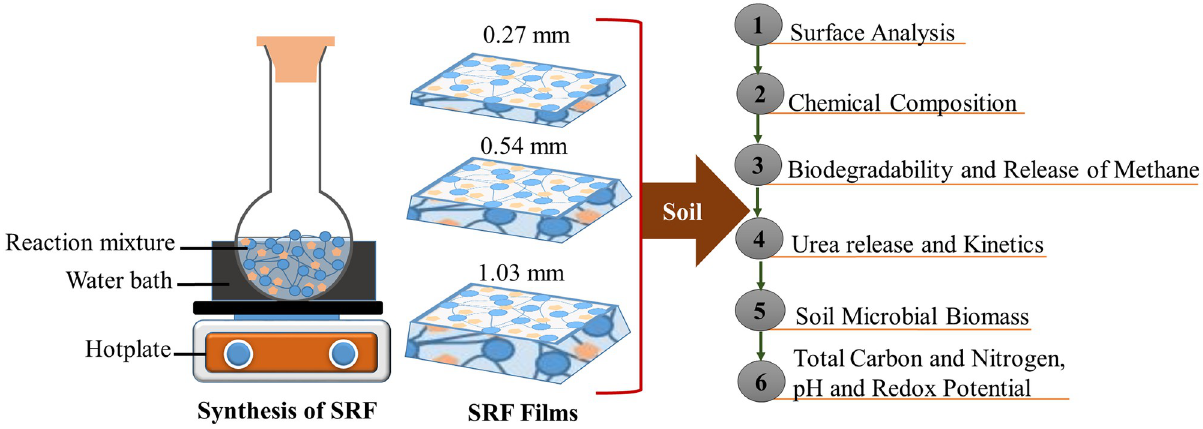
Fig 1. Synthesis, preparation and testing scheme for variable thickness of the SRF in soil